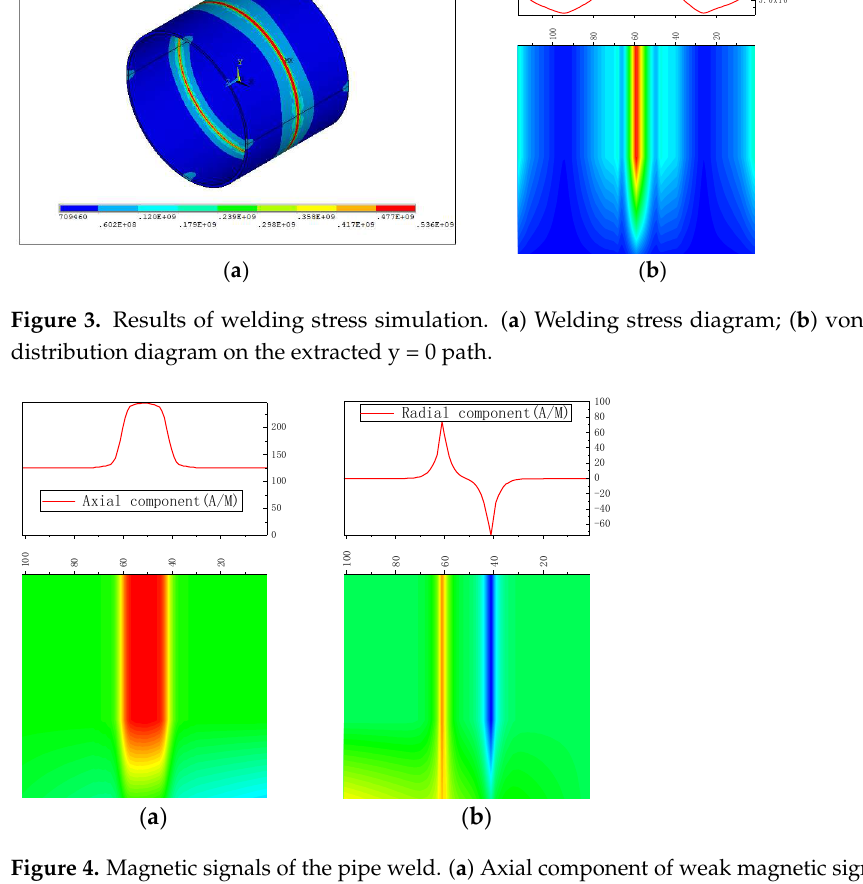
Figure 4. Magnetic signals of the pipe weld. ( a ) Axial component of weak magnetic signal; ( b ) radial component of weak magnetic signal.